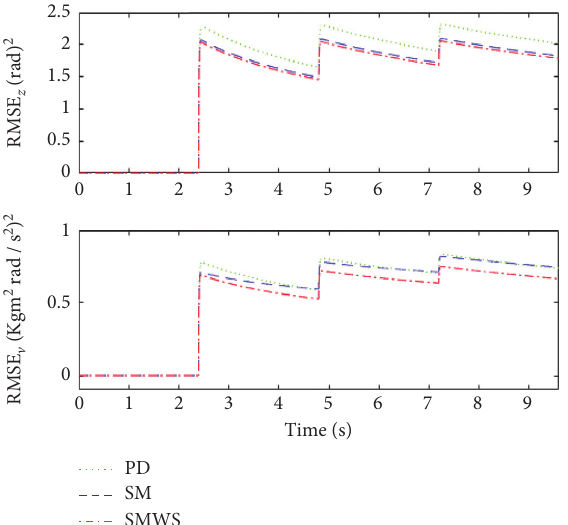
Figure 8: RMSE of the first electricity generator.